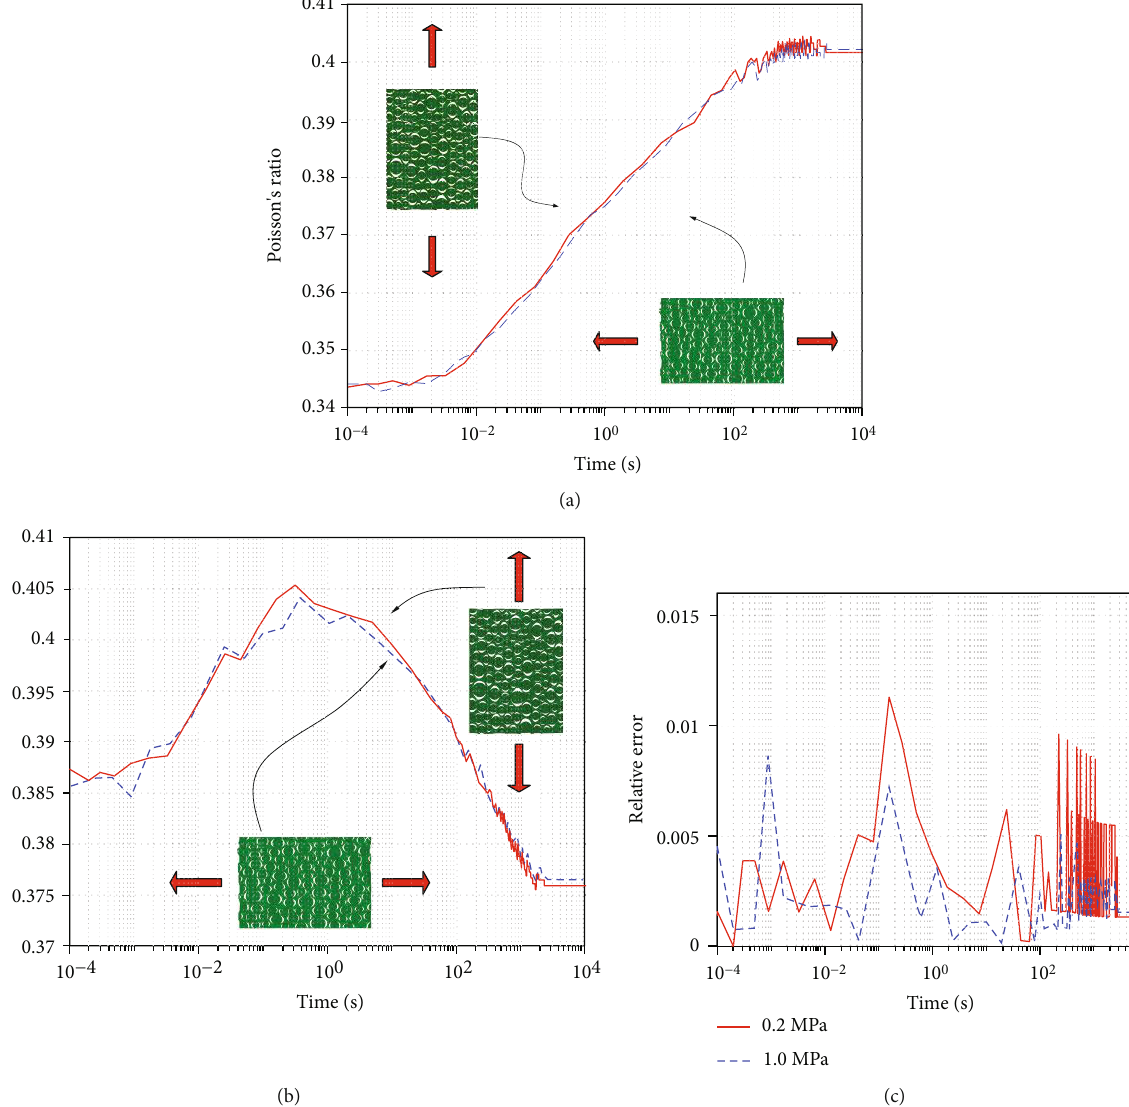
Figure 20: The curves of Poisson ’ s ratio versus time under di ff erent loading directions when cohesive strength equals to (a) 0.2MPa and (b) 1.0MPa. (c) The relative error between Poisson ’ s ratio under di ff erent loading directions.